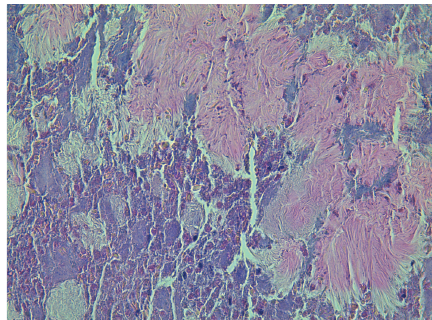
Figure 3: Actinomycetes can be seen forming colonies of filamen- tous sulfur granules surrounded by numerous polymorphonuclear cells (hematoxylin and eosin staining,